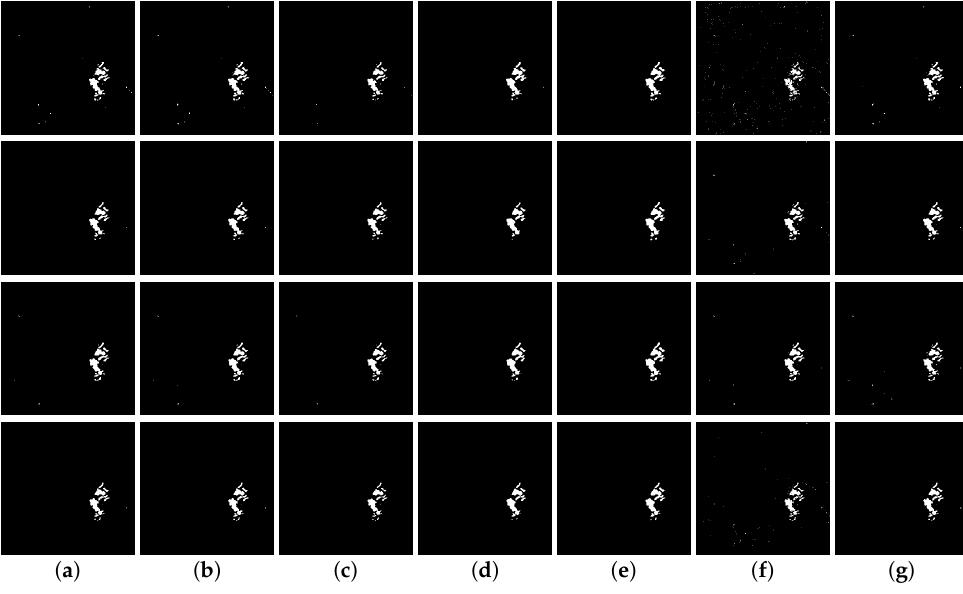
Figure 7. Results of ( a ) PCAK, ( b ) SPC, ( c ) FCM-MRF, ( d ) GTLC, ( e ) SACD, ( f ) Conradsen, and ( g ) SC-SGD on the Bern dataset. From top to bottom: each row contains the results of the input image, and images filtered by MMSE, SAR-BM3D, and PPB filters, respectively.